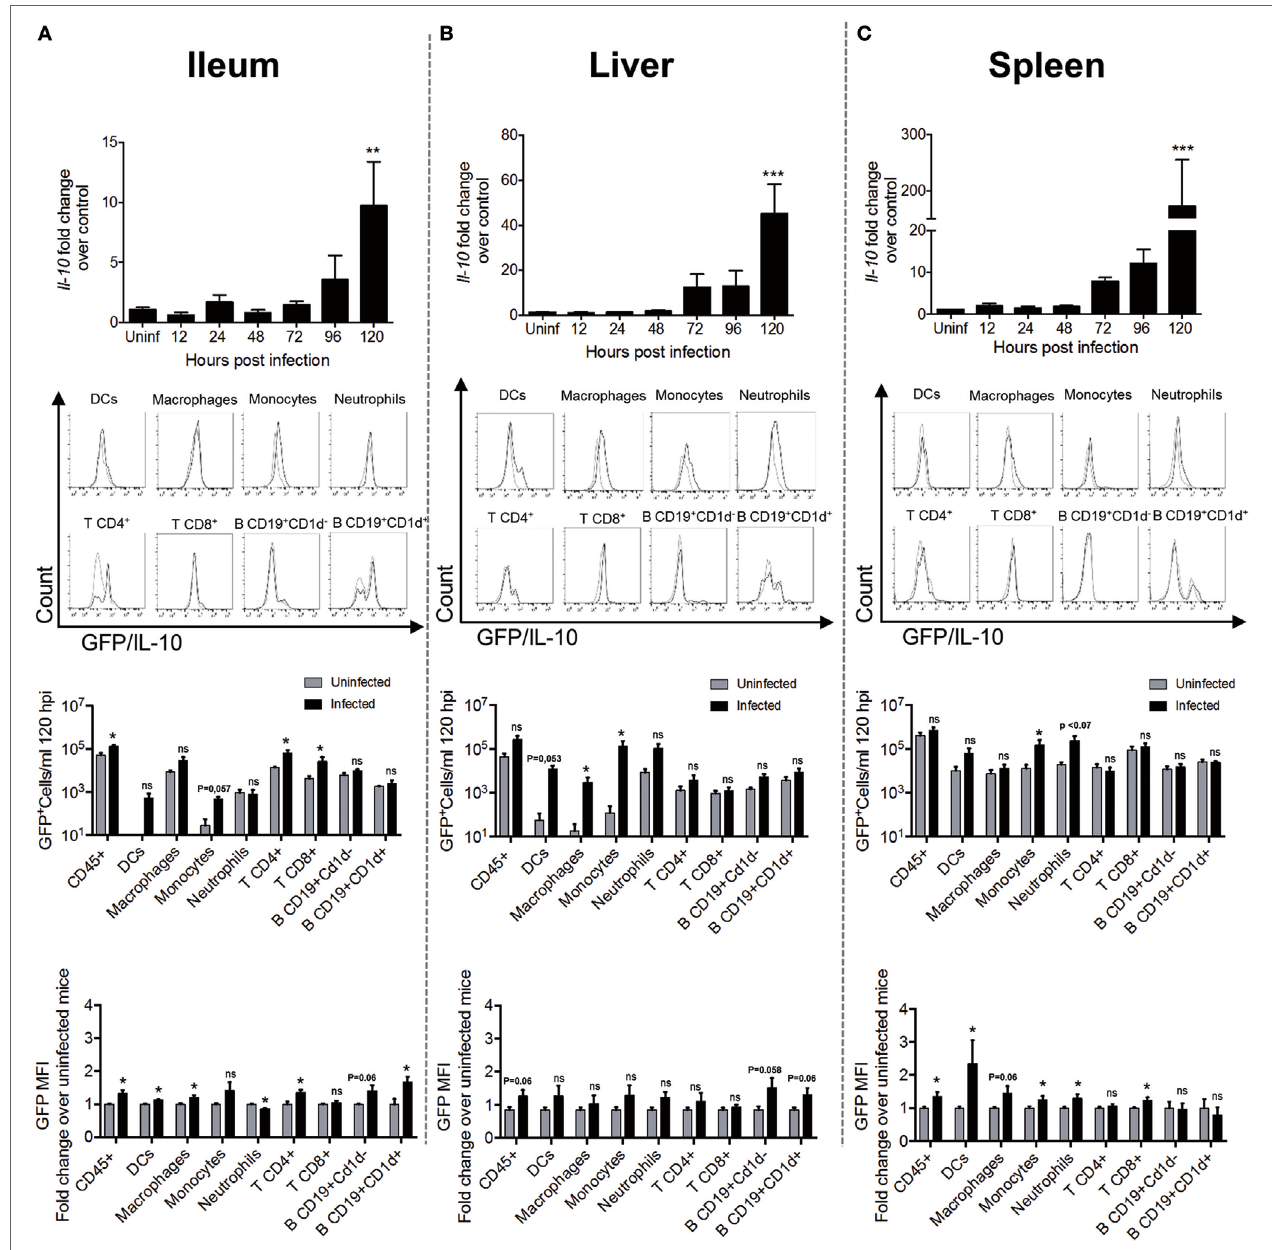
FigUre 2 | Interleukin-10 (IL-10) production significantly increases in target tissues after 120 h of S. Typhimurium infection. In the panels of the upper row, Il-10 messenger RNA (mRNA) production was quantified by RT-PCR in ileum (a) , liver (B) , and spleen (c) of infected WT mice at different time post-infection. The panels of the second row show representative flow cytometry histograms obtained to identify the cell source of IL-10 production at 120 h post infection in ileum (a) , liver (B) , and spleen (c) of IL-10/GFP VertX that were orally infected by S. Typhimurium. In the third-row panels, a quantification of IL-10 producing total leukocytes, dendritic cells (DCs), macrophage, monocytes, neutrophils, CD4 + T cells, CD8 + T cells, CD19 + CD1d − B cells, and CD19 + CD1d + B cells in ileum (a) , liver (B) , and spleen (c) were identified by flow cytometry. The quantification of IL-10/GFP + cells was performed using count bright beads. The last row panels show the fold change of the medium fluorescence intensity of GFP/IL-10 in myeloid and lymphoid cell types during S. Typhimurium infection at 120 h post infection. For Il-10 mRNA production, ** P < 0.01; *** P < 0.001 (one-way analysis of variance test with a posteriori multiple comparison